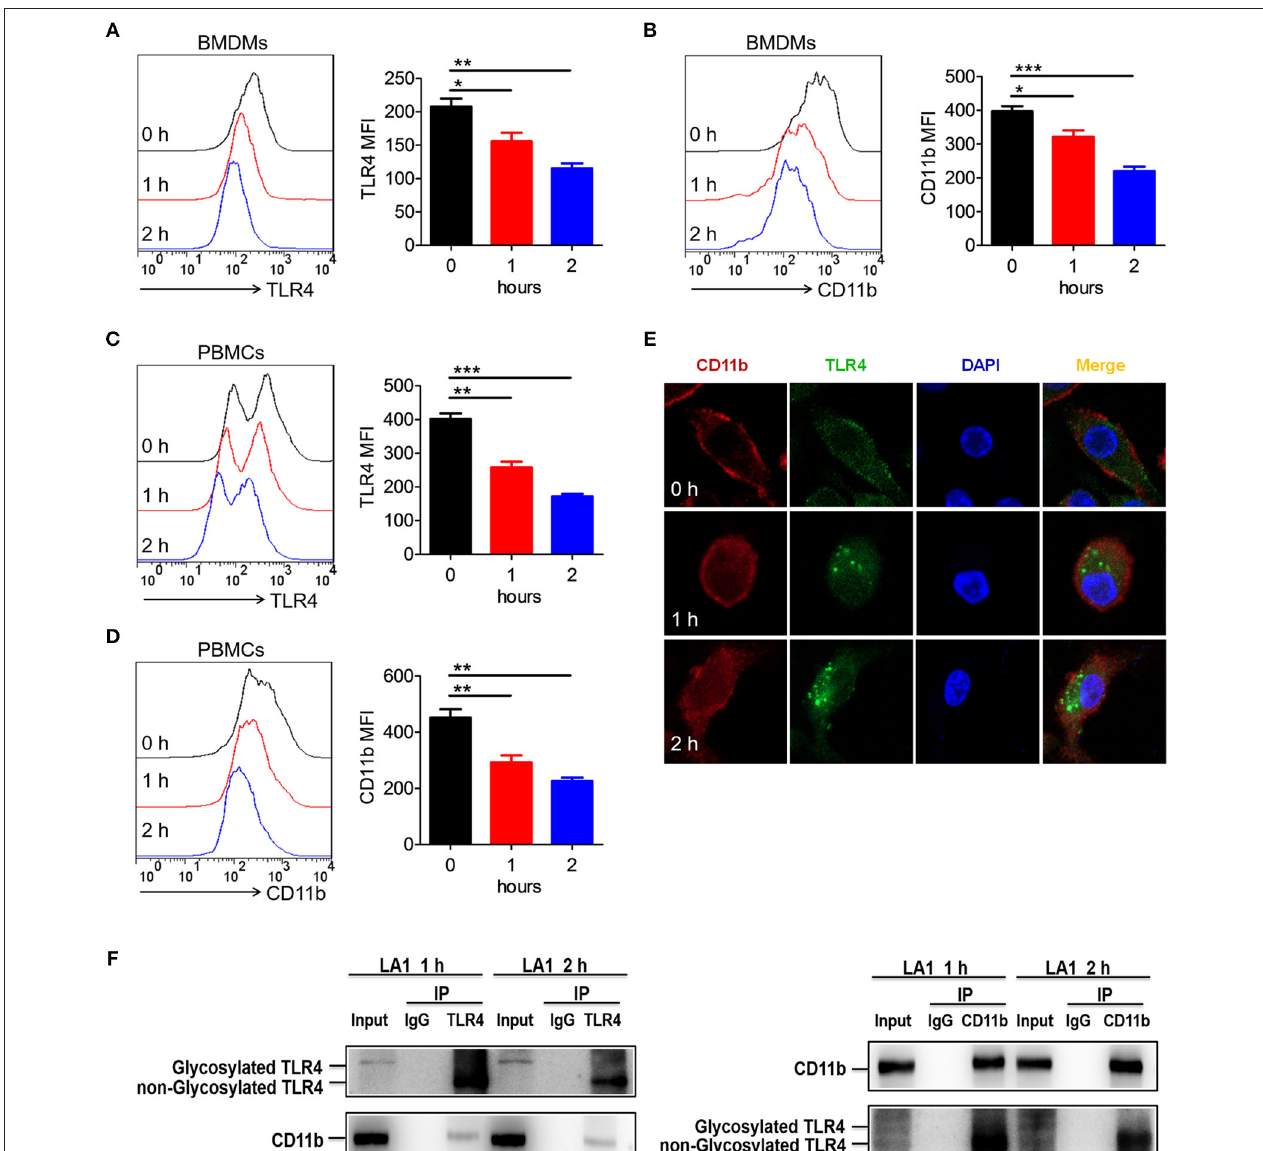
FIGURE 7 | Activation of CD11b by LA1 could endocytose TLR4 in macrophages. (A, B) BMDMs were treated with LA1 (20 µ M) for 1 and 2h. FACS analysis was performed to assess the expressions of TLR4 (A) and CD11b (B) in BMDMs. (C, D) C57BL/6 mice were stimulated with LA1 (40 µ g/g of body weight) for 1 and 2h. FACS analysis was performed to assess the expressions of TLR4 (C) and CD11b (D) in PBMCs. (E) Slides containing BMDMs were treated with LA1 (20 µ M) for 1 and 2h, and then, the cells were fixed and permeabilized. The cells were initially stained with anti-TLR4 mAb and anti-CD11b mAb, followed by incubation with an Alexa Fluor 488- and 647-conjugated secondary antibodies. Finally, they were analyzed using a confocal microscope. Red represents CD11b; green represents TLR4; light blue represents nuclei with DAPI; and yellow represents merged TLR4 and CD11b. (F) After treated with LA1 (20 µ M) for 1 or 2h, BMDMs were lysed in a modified RIPA buffer. After entrifuged, one aliquot of the supernatant was saved as the input control, the remainder was separately incubated with anti-CD11b antibody, anti-TLR4 antibody and negative control IgG antibody, followed by pull-down with 30 µ l Protein A Agarose beads. The beads were then collected by centrifugation and washed three times with cold PBS. The immunoprecipitates were eluted by boiling in loading buffer and subjected to western blot analysis along with input sample as described above. Data shown are representative of three independent experiments. Error bars represent S.E.M. * p < 0.05, ** p < 0.01, *** p < 0.001, as determined by one-way analysis of variance (ANOVA) post-hoc Tukey Multiple Comparison